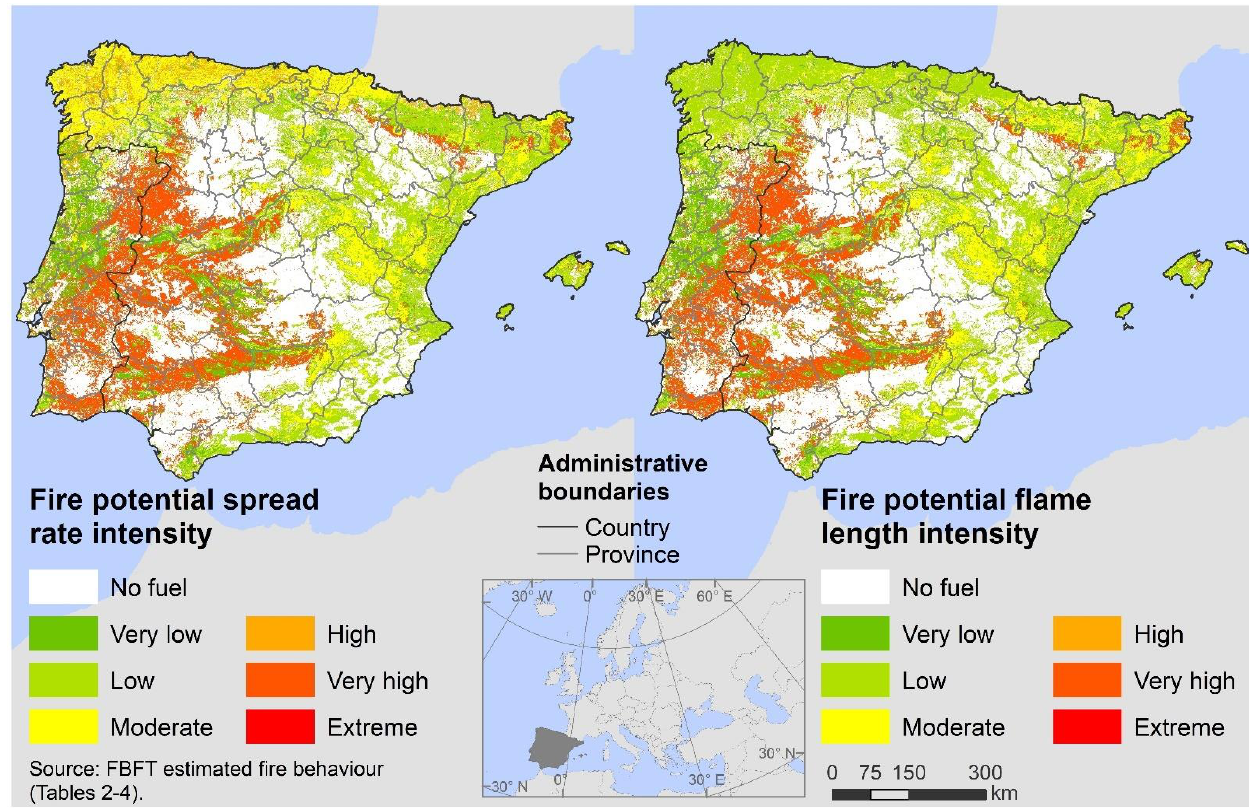
Figure 8. Maps of the FBFT-adapted generic climate fuels’ fire potential spread rate and flame length for surface fires (see Table A1 in the Appendix A) for the Iberian Peninsula and the Balearic Islands (2020 – 2021).